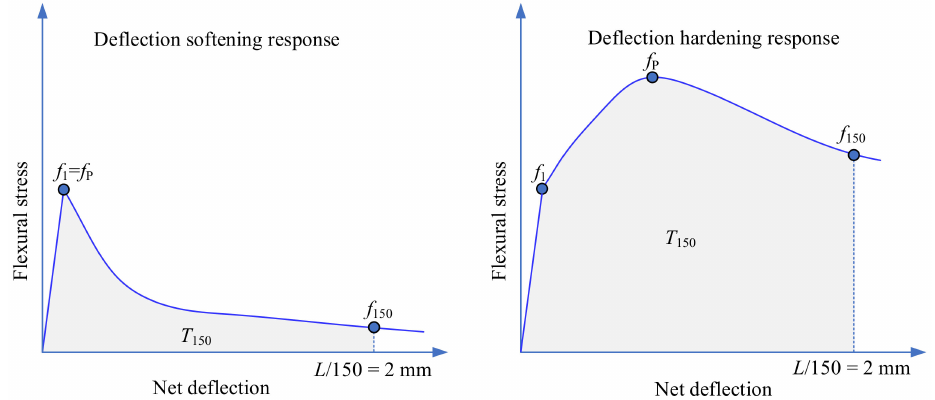
Figure 3. Typical flexural strength-deflection